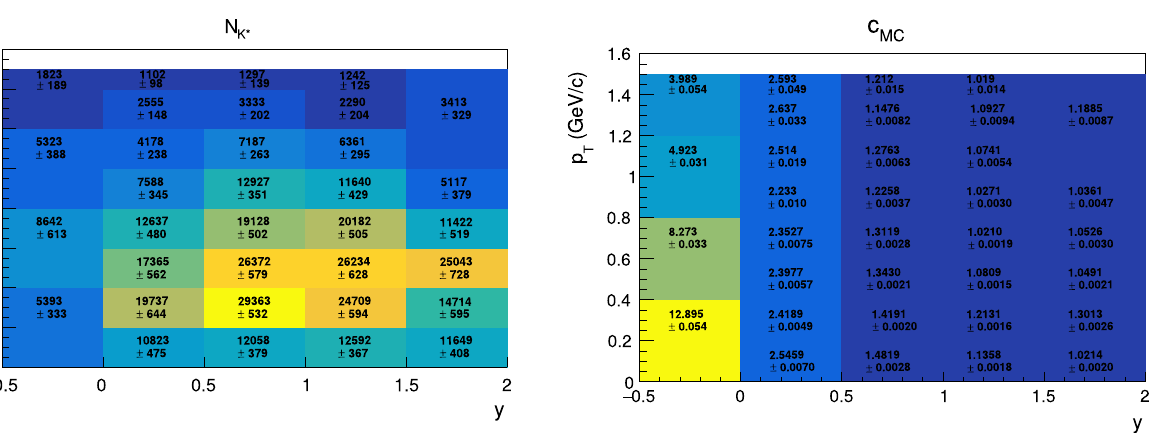
Fig. 6 Uncorrectednumbersof K ∗ ( 892 ) 0 obtainedfromtheextraction procedure described in Sect. 3.6. The values are shown with statistical uncertainties